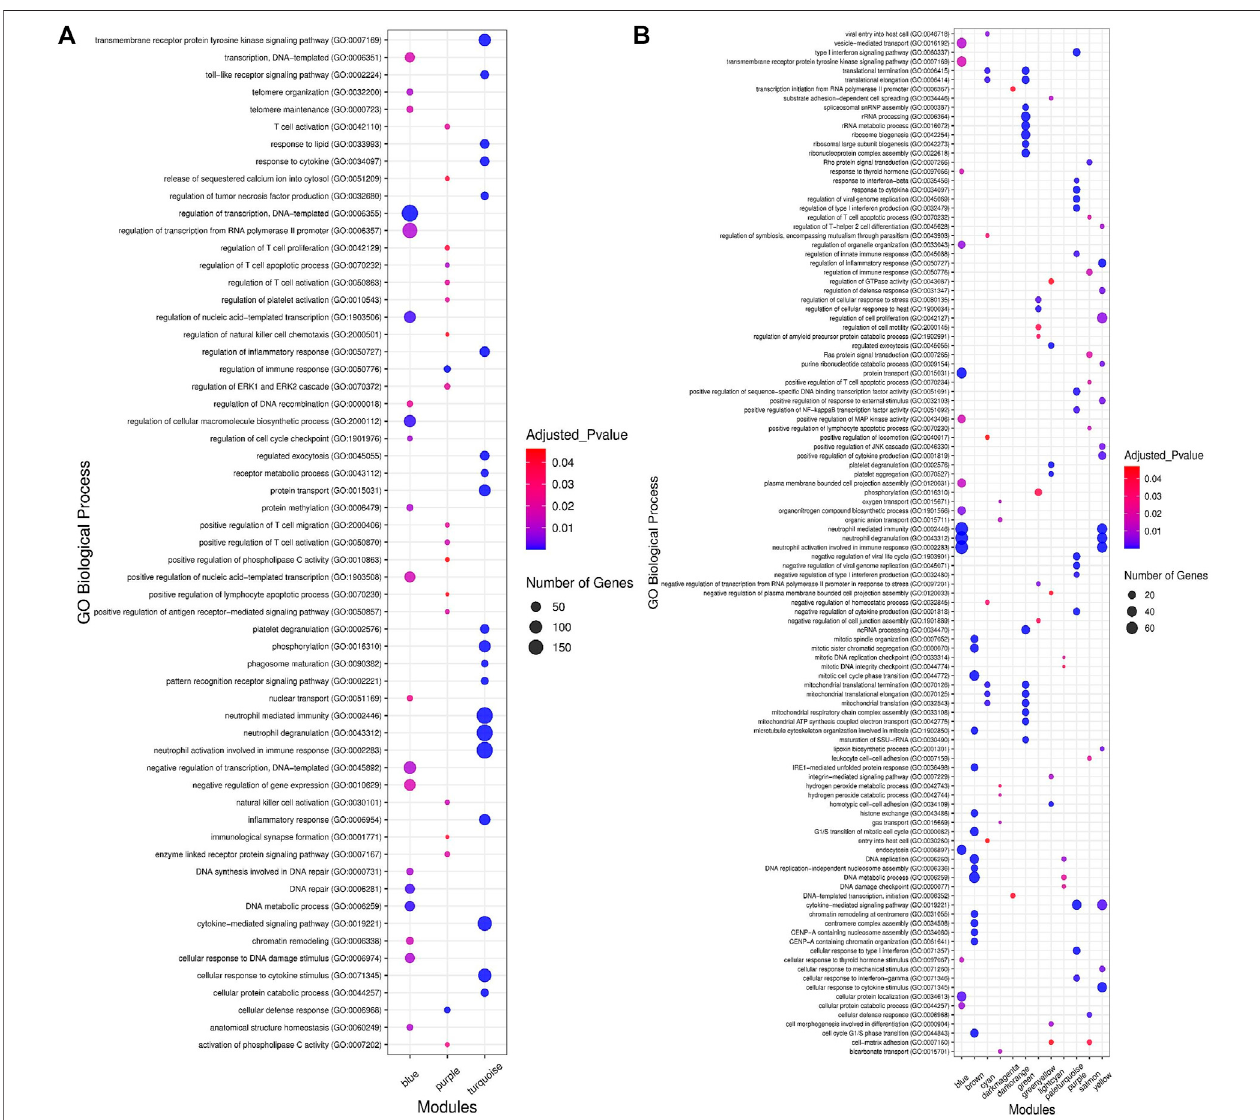
FIGURE 4 | Functional enrichment analysis results. (A) The top 20 signi fi cant biological processes for signi fi cant highly correlated and biologically related modules to bovine respiratory disease (BRD). Color and size and each point represent − log2(FDR) and number of genes for each term, respectively. (B) The top 15 signi fi cant biological processes for signi fi cant enriched nonpreserved modules. Color and size and each point represent − log2(FDR) and number of genes for each term, respectively.